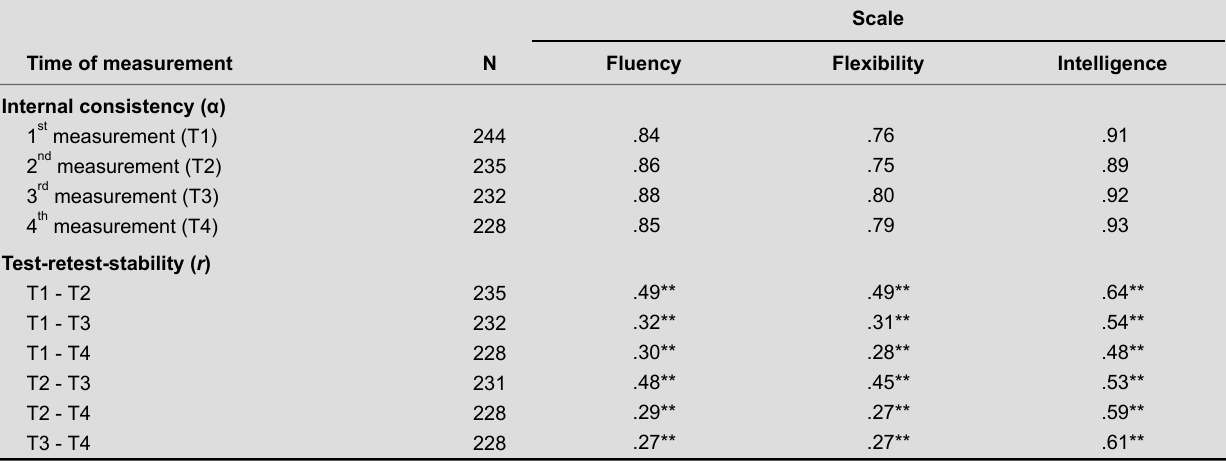
Coefficients of Internal Consistency (Cronbach’s α) at the Four Times of Measurement and Coefficients of Test-Retest Stability Between the Four Times of Measurement in the Luxembourg